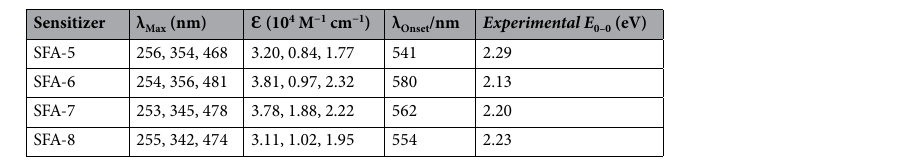
Table 1. UV–Vis absorption spectra of the synthesized SFA-5–8 sensitizers.